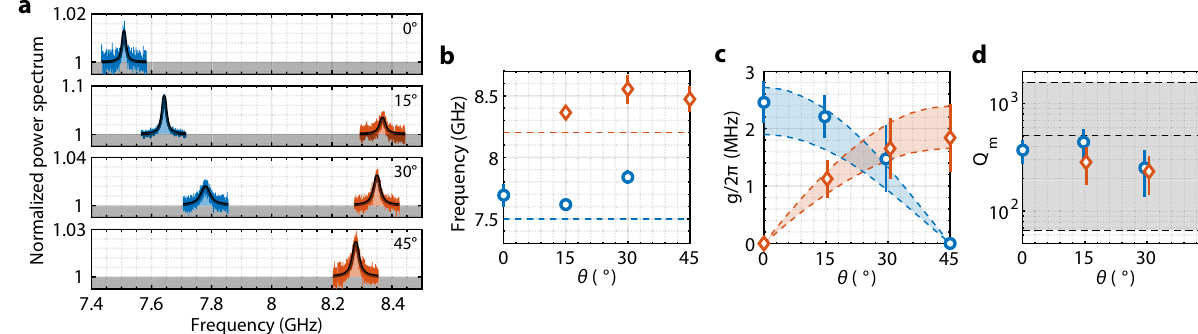
Fig. 4 Room temperature mechanical spectroscopy. a Measured mechanical noise power spectrum for one device each for θ = 0°, 15°, 30°, and 45°. b Mechanical frequency distribution of a group of fi ve devices for each θ . Error bars indicate one standard deviation (error bars smaller than the symbol are not shown). Dashed lines are the simulated mechanical frequencies. c Unit-cell optomechanical coupling. The dashed lines correspond to simulated coupling for w = 28 nm (top) and 40 nm (bottom). d Total quality factor of the mechanical modes. The dashed lines are the estimated bound and mean from the simulation of a 1 × 4 super-cell